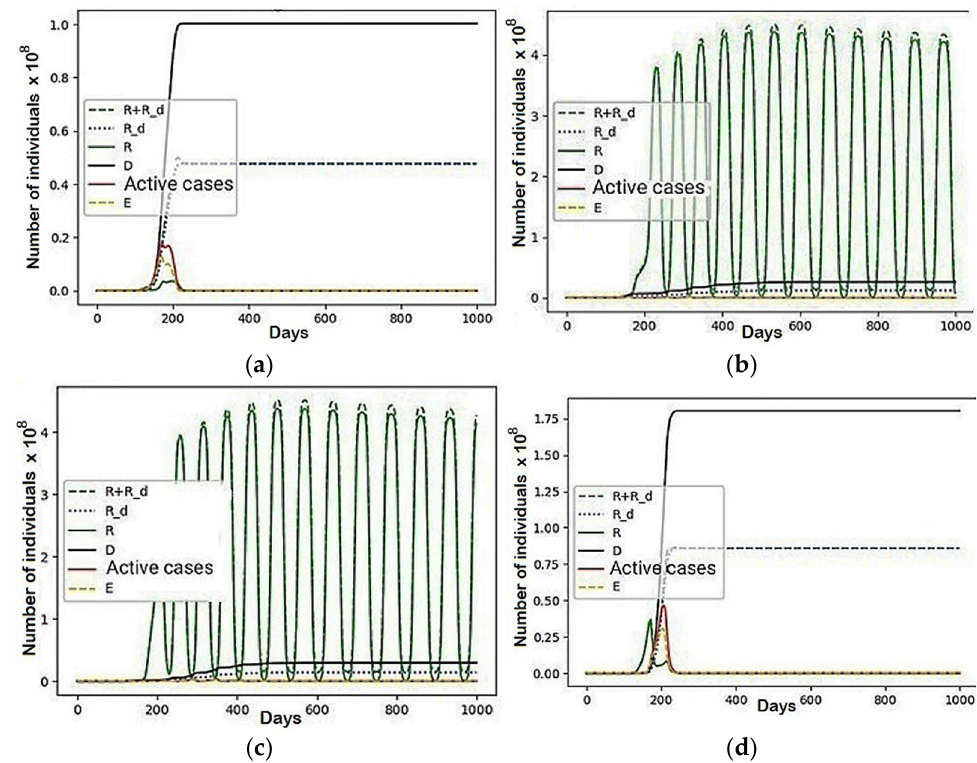
Figure 6. The graphical results a scenario in which 𝑎 (cid:2869) = 1, 𝑏 (cid:2869) = −0.1, 𝑏 (cid:2872) = 0.05, 𝑐 (cid:2869) = −0.15, 𝑐 (cid:2872) = 0.1, 𝑑 (cid:2869) = −0.3,𝑑 (cid:2870) = −0.7 , and the rest are equal to zero: ( a ) Region 1; ( b ) Region 2; ( c ) Region 3; ( d ) Region